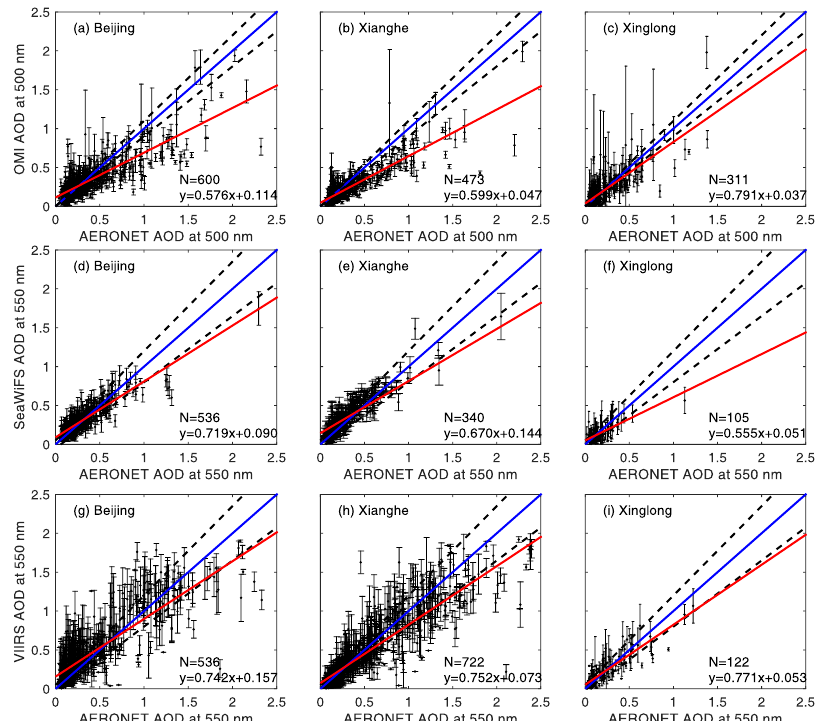
Figure 4. Scatter plots representing the evaluation of OMI (the Ozone Mapping Imaging) ( a – c ), SeaWiFS (the Sea-Viewing Wide Field-of-View Sensor) ( d – f ), and VIIRS (the Visible Infrared Imaging Radiometer) ( g – i ) AODs against the ground-based AERONET AODs at the Beijing, Xianghe, and Xinglong sites. The solid red and blue lines represent the linear regression and 1:1 fitting lines, respectively. The dashed black lines indicate the uncertainty envelopes with 0.1 AOD for OMI and ± 0.05 + 0.15 AOD for SeaWiFS and VIIRS.